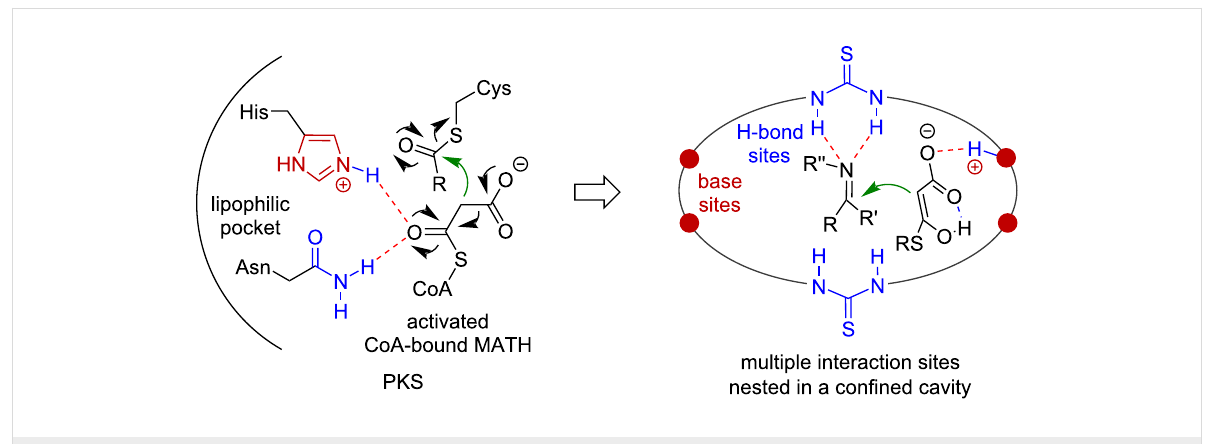
Figure 1: Design of PKS-inspired multifunctional amino-thiourea macrocycle catalysts.